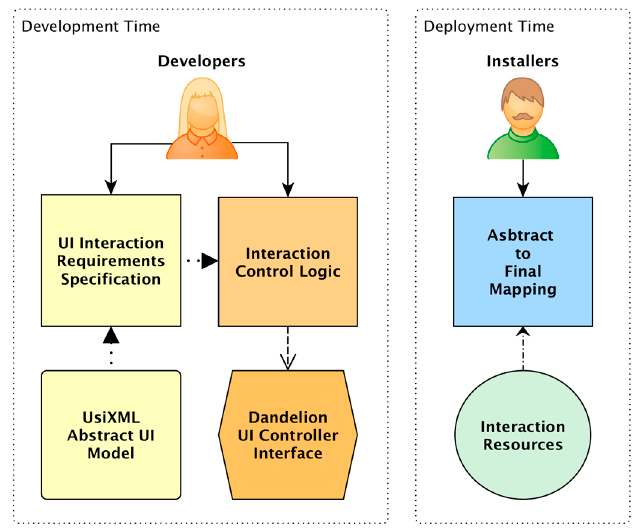
Figure 3. Dandelion adaptable UIs development process.